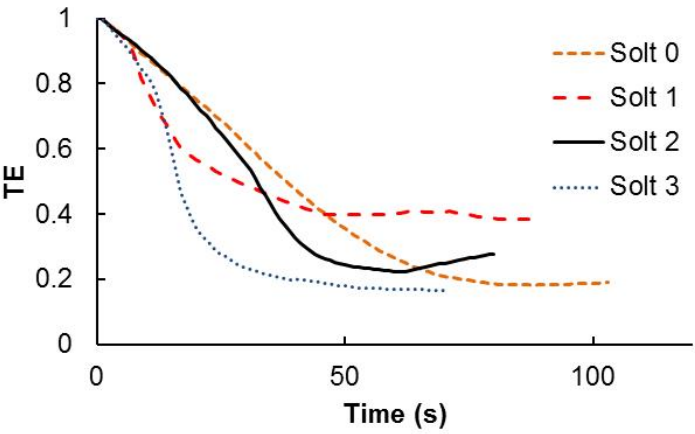
Figure 3. Transmitted efficiency as a function of the exposure time for the different chemical compo- sitions analyzed.